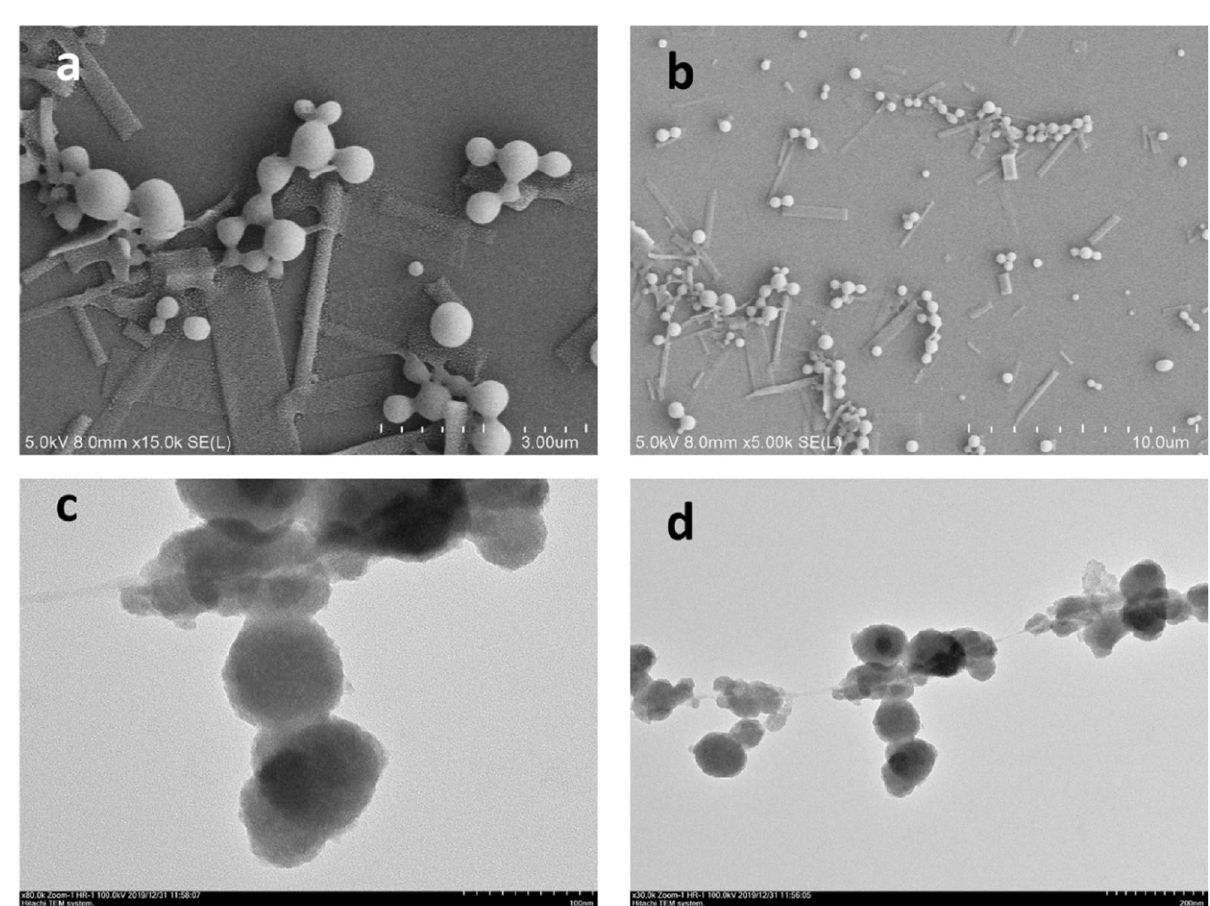
Figure 7. SEM (“ a ” and “ b ”) and TEM (“ c ” and “ d ”) images of the as prepared Fe 3 O 4 -NPs using Chlorella K01 extracts as capping and reducing